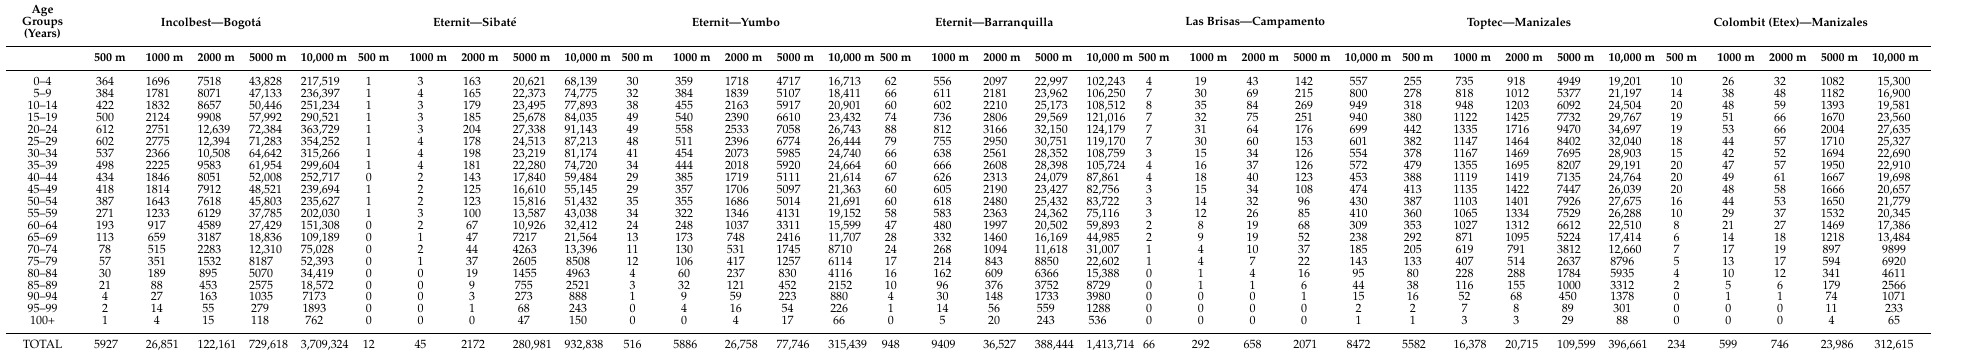
Table 4. Number of people living around the seven main asbestos processing/mining sites in